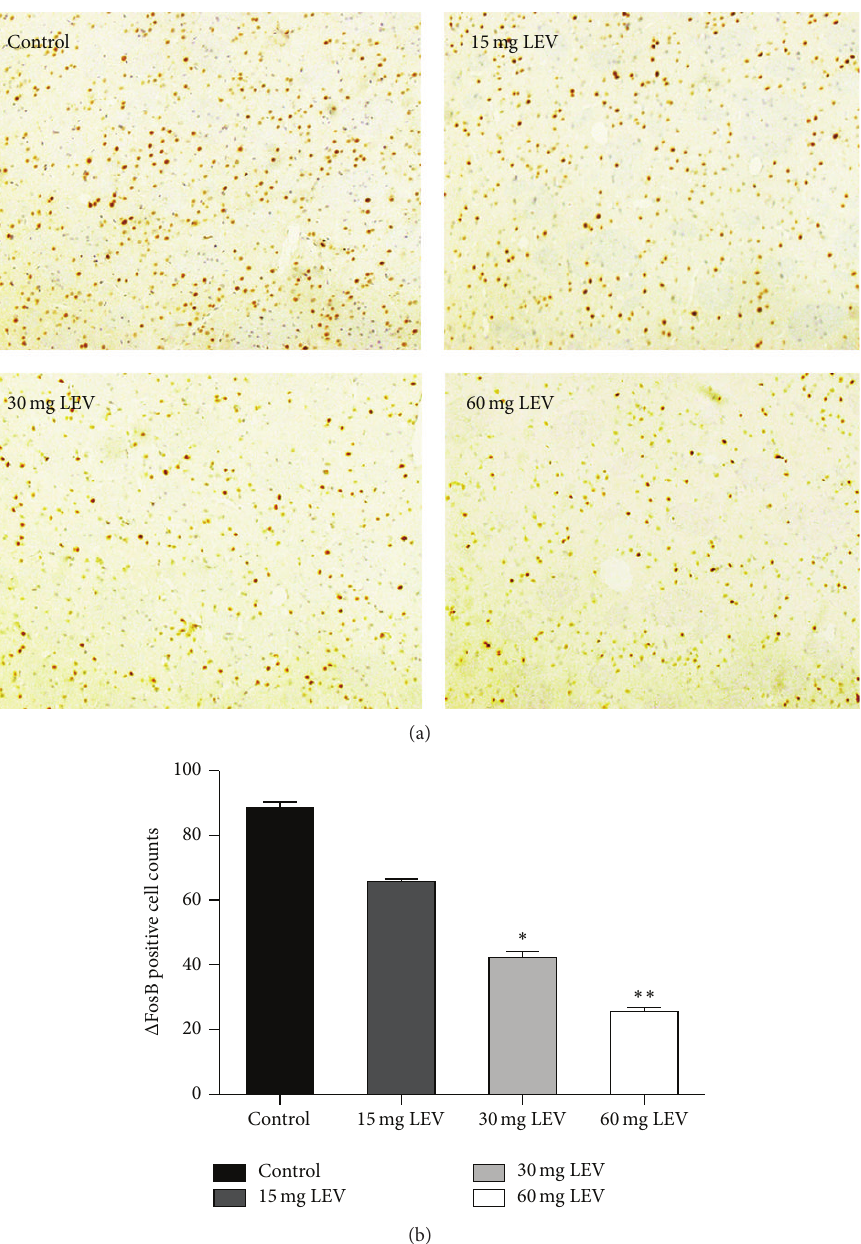
Figure 2: Levetiracetam-induced changes in FosB/ Δ FosB immunostaining of the dorsolateral portion of the striatum. (a) Images of striatal slices from the lesion side of an animal from each treatment group (control, 15, 30, and 60 mg/kg levetiracetam denoted as LEV; × 200). (b) Immunoreactive cell count in each treatment group. Values are mean ± SEM. ∗ 𝑃 < 0.05 and ∗∗ 𝑃 < 0.01 versus control group ( 𝑛 = 4 per